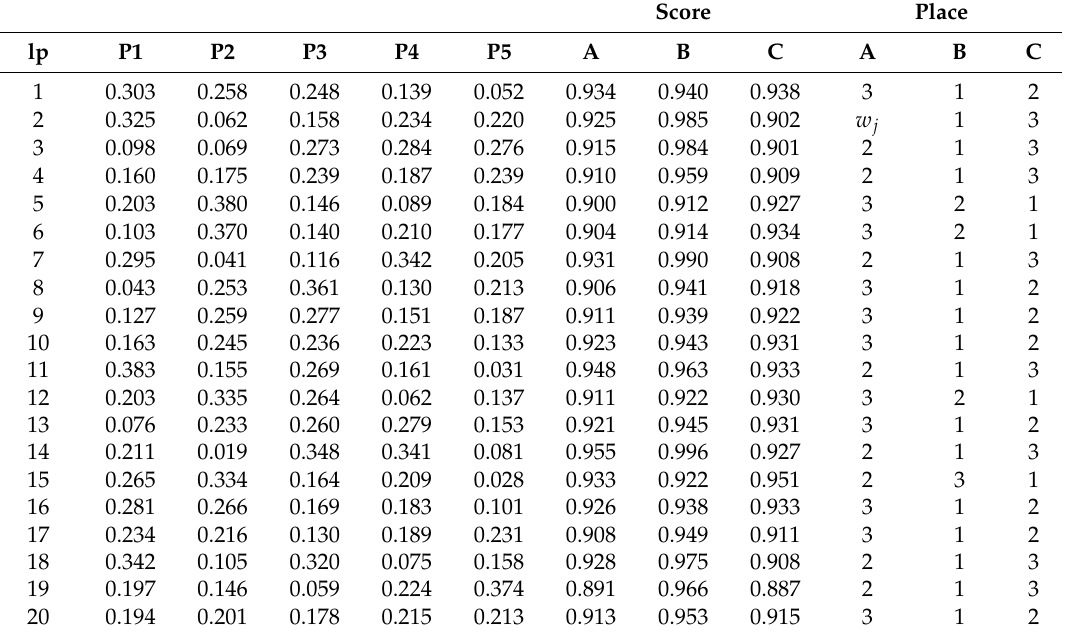
Table 14. Simulation showing scores for di ff erent weight values. Score